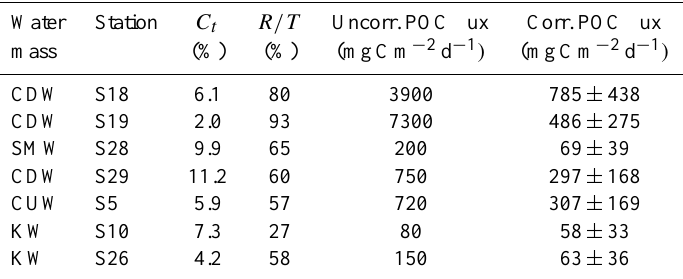
Table 4. Detailed values of C t , R/T , uncorrected POC flux (Uncorr. POC flux) and corrected POC flux (Corr. POC flux ± uncertainty) in the different areas of the ECS. Water